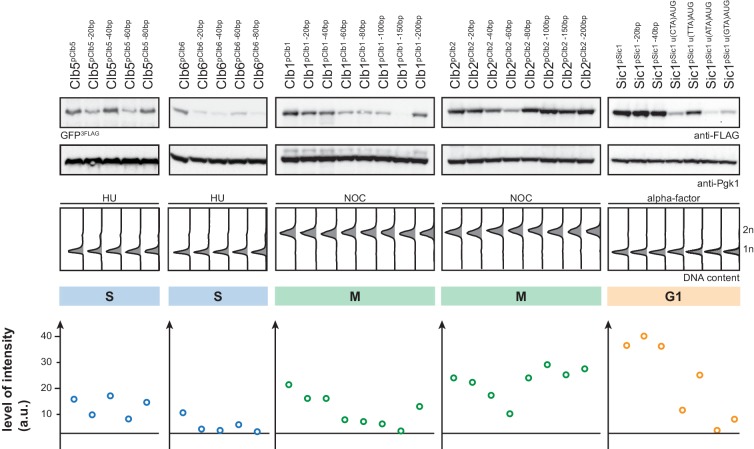
5'UTR truncations and upstream out of frame ATGs cripple peak expression levels of cell cycle tag constructs.Western blot analysis of Clb5pClb5-, Clb6pClb6, Clb1pClb1-, Clb2pClb2- and Sic1pSic1-tagged GFP expressed from constructs with truncated 5’UTR and upstream out of frame ATGs in HU (S), NOC (M) and α-factor (G1) arrested cells. Middle: DNA content measurements of corresponding samples by flow cytometry. Bottom: Expression levels were quantified using Image-J.